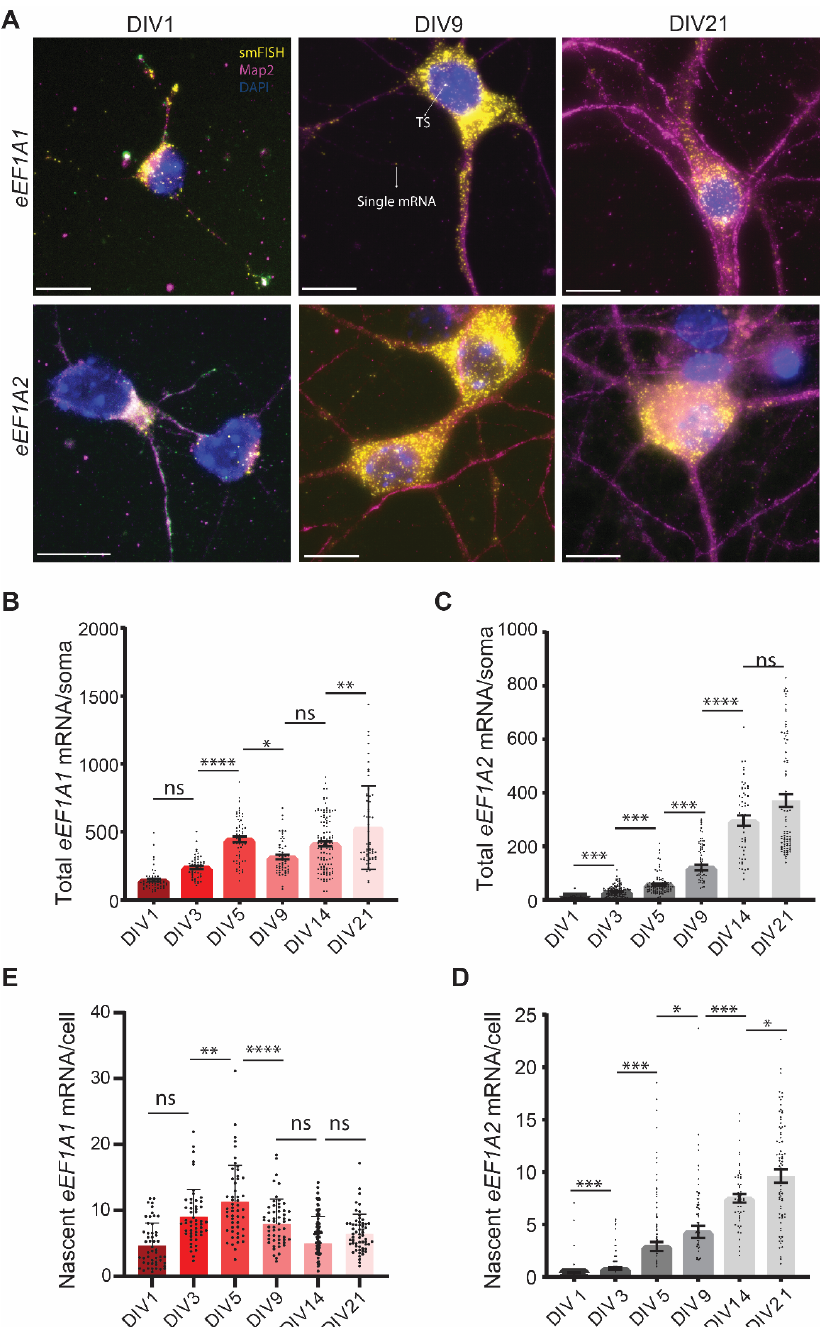
Figure 2. Expression of eEF1A1 and eEF1A2 mRNAs in the soma through neurodevelopment. ( A ) smFISH-IF to detect eEF1A1 or eEF1A2 mRNAs in soma and dendrites. Representative smFISH-IF at the indicated DIVs. Nucleus stained with DAPI (blue), eEF1A1 and eEF1A2 smFISH colored in yellow, and dendrites stained by IF to detect Map2 indicated in magenta. TS indicates the sig- nal of a transcription site and the arrow in DIV9 indicates the signal from a representative single mRNA. Scale bar is 10 mm. ( B , C ) Number of mature eEF1A1 ( B ) and eEF1A2 ( C ) mRNAs per soma through neurodevelopment. ( D , E ) Number of nascent eEF1A1 ( D ) and eEF1A2 ( E ) transcripts per nucleus through neurodevelopment. Total number of neurons analyzed in four experiments, eEF1A1 N = 81–118, eEF1A2 N = 87–172. Statistical analysis to compare a specific DIV with the next devel- opmental time point was conducted with one-way ANOVA ( p -value ns > 0.05, * < 0.05, ** < 0.01, *** < 0.001, **** <